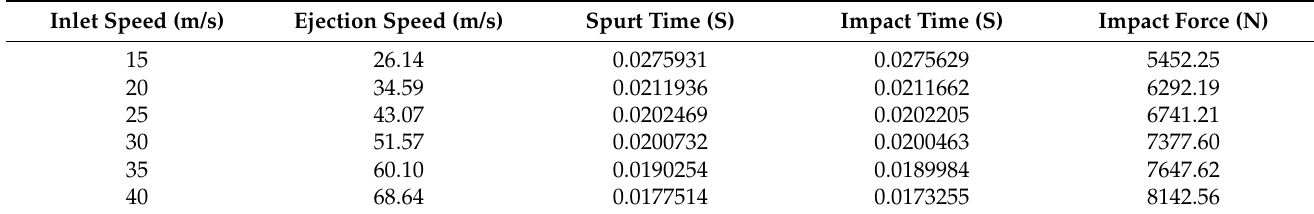
Table 6. Velocity–impact force relationship.